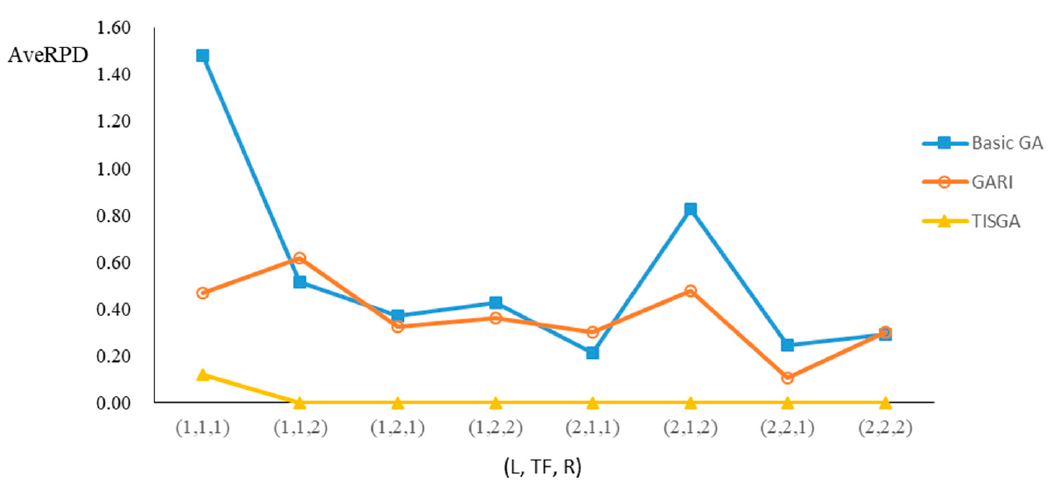
Figure 8. Comparison results for n = 20 with combinations of (L, TF, R).